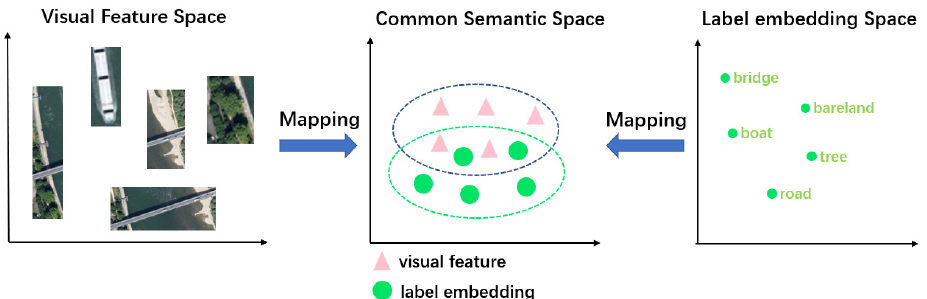
Figure 5. Illustration of semantic transformation. Mapping visual features (e.g., f s , f o ) and label embeddings (e.g., v s , v o ) to a common semantic space via the learned transformation matrixes (e.g., W s , W o